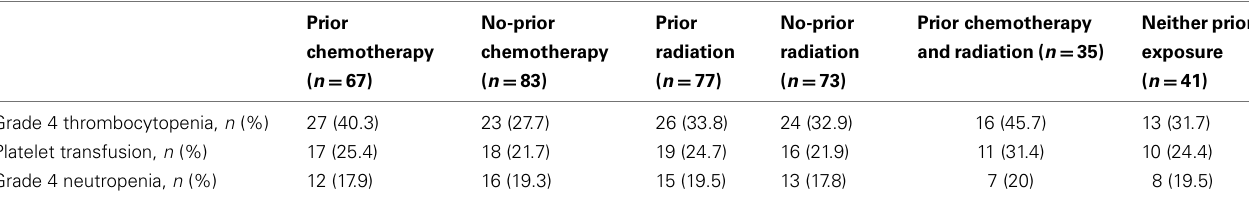
Table 3 | Hematologic toxicity by prior